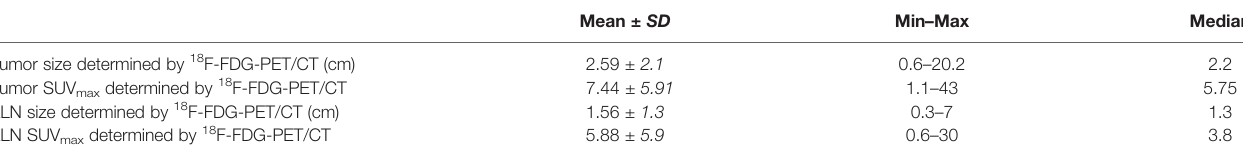
TABLE 2 | Tumor and lymph node characteristics by PET/CT ( N =